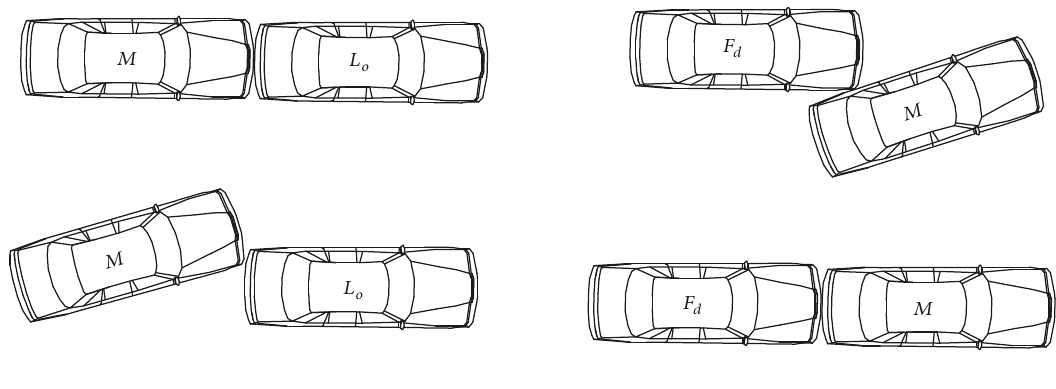
Figure 3: Collision types between vehicles while changing